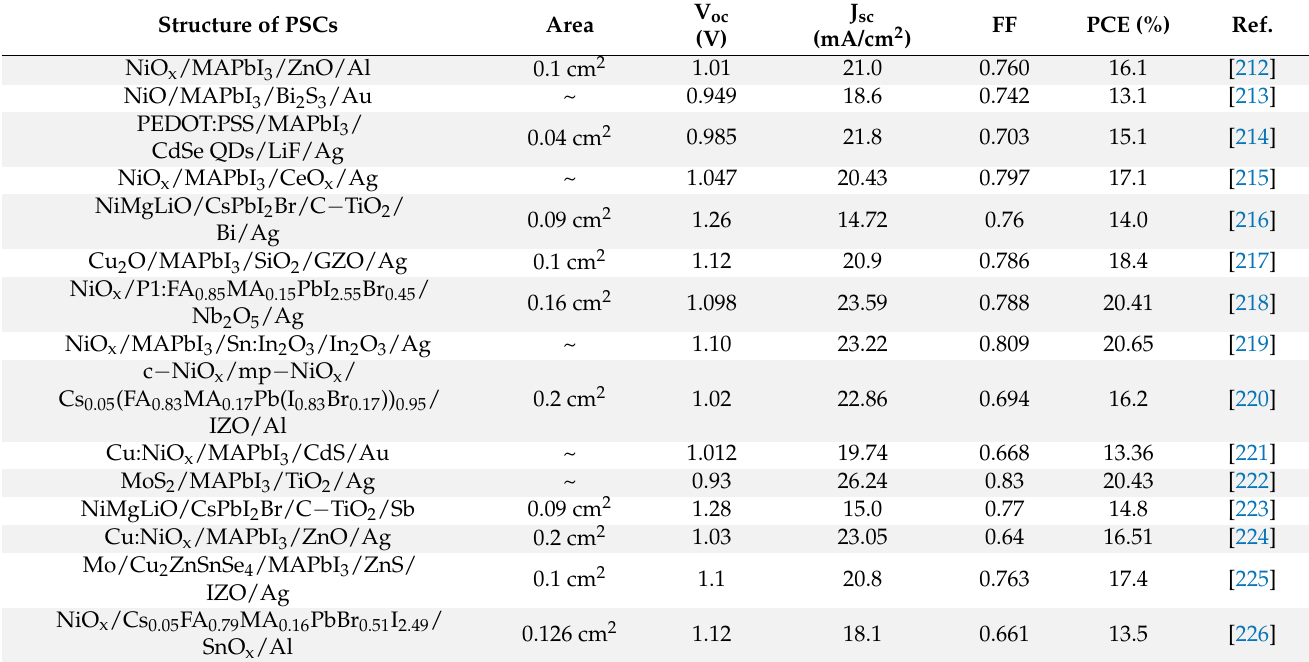
Table 19. Performances of several representative inverted PSCs on the basis of inorganic